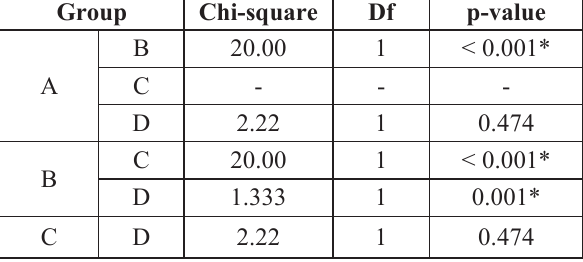
Table-2: Multiple Comparisons for Secondary follicle among the Groups. (*p value ≤ 0.05 considered statistically significant, df Degree of freedom -